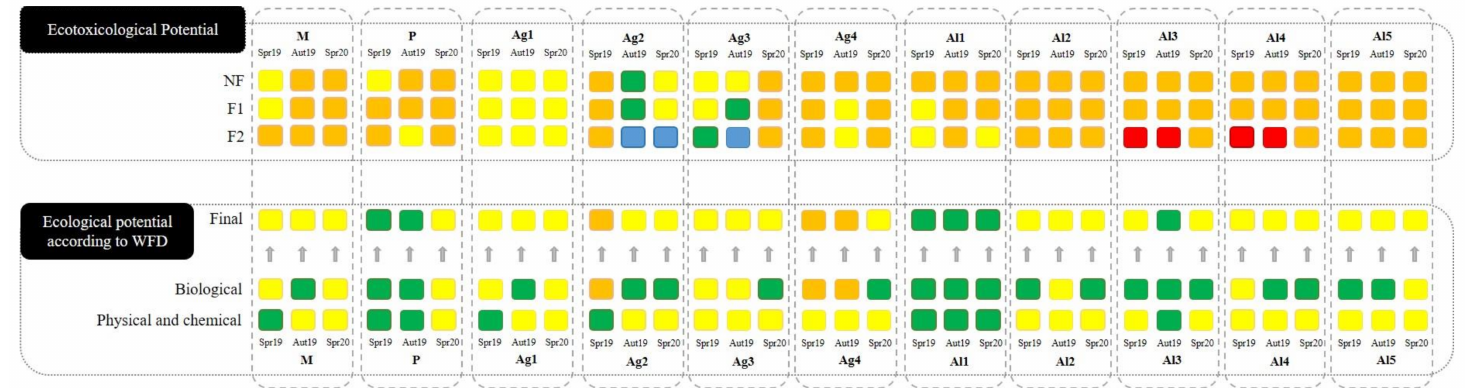
Figure 6. Ecotoxicological potential of the sampling sites and periods, according to natural water treatments (NF, F1 and F2) ecotoxicity results (defined in Table 2) and ecological potential according WFD parameters (Table